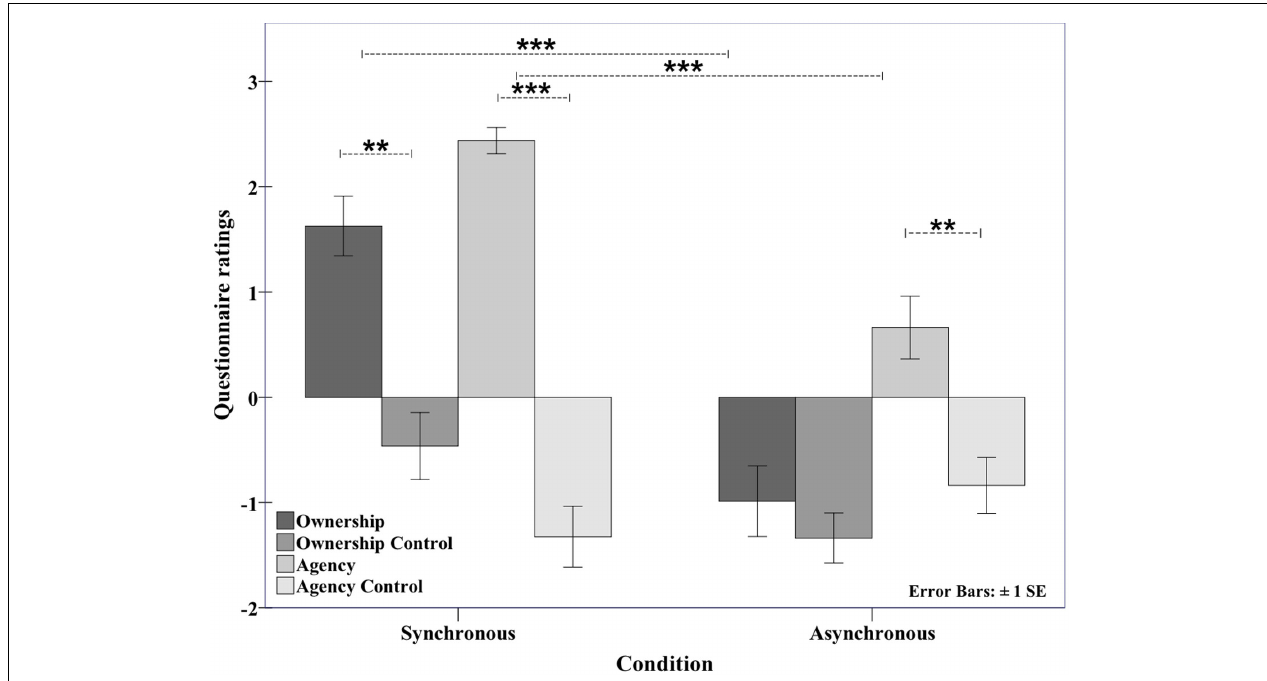
were significantly greater than their respective control statements in the synchronous condition. Additionally, both the ownership and agency statement scores were greater in the synchronous than asynchronous condition (see Experiment 1: Questionnaire results for the synchronous versus asynchronous movements). ** p < .01; *** p < .001.